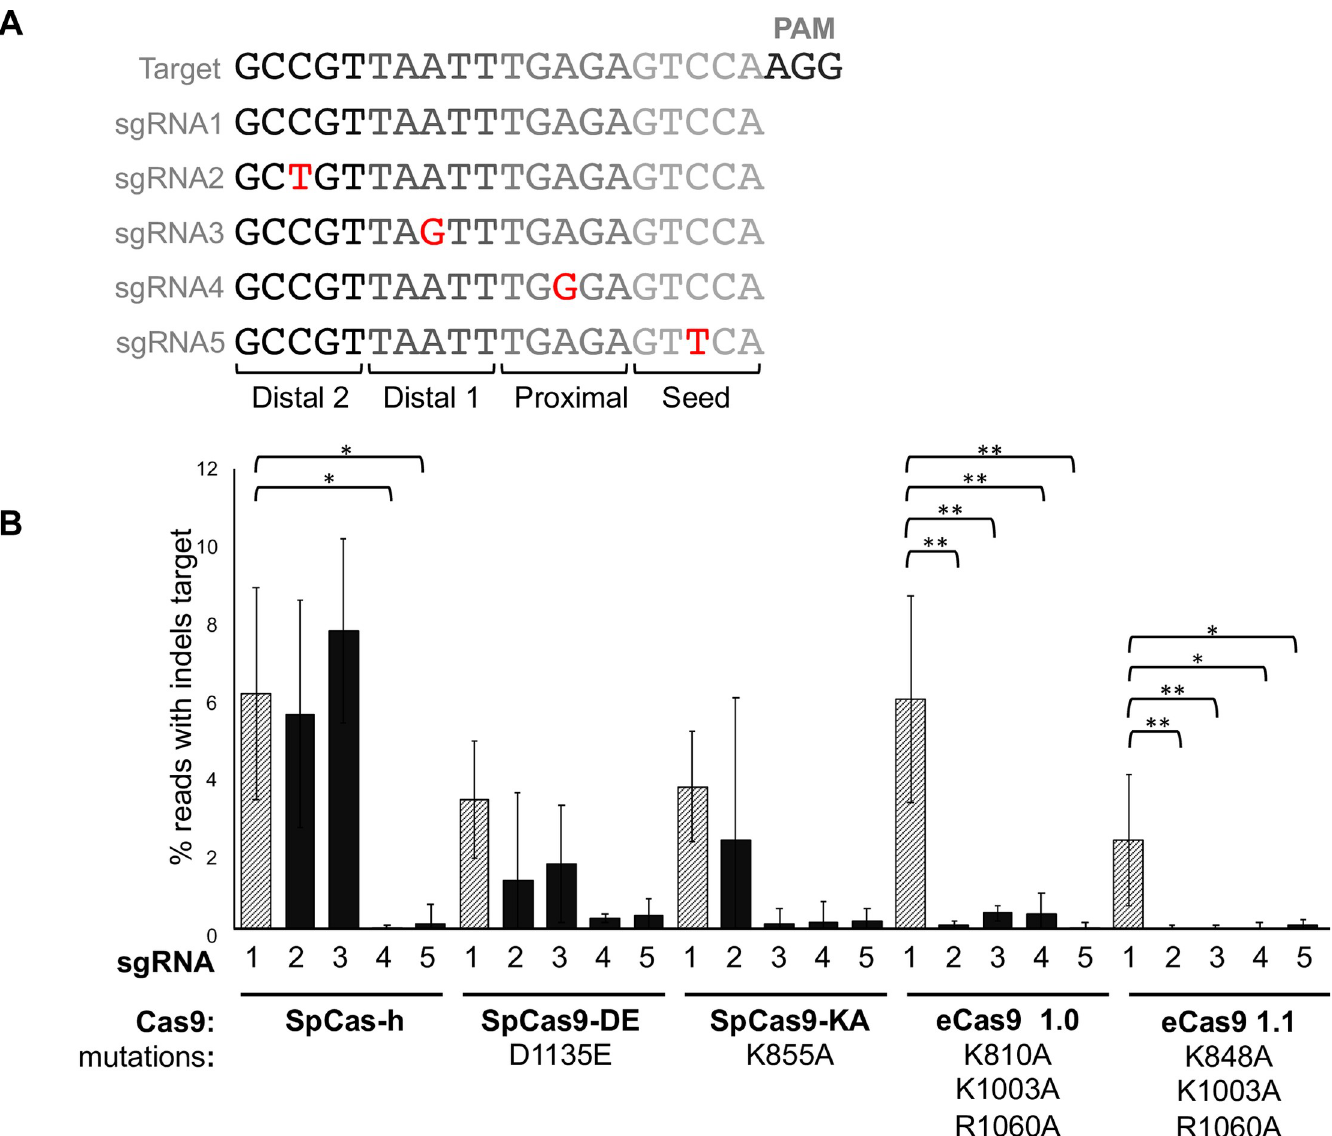
Fig 3. Assessment of Cas9 specificity at an identical target. (A) Schematic showing transversions in four regions of the spacer sequences of sgRNAs targeting NbPDS1 (B) The efficiency of targeted mutagenesis is impacted by transversions in the spacer. Shaded bars represent a perfect match of the spacer to the target, black bars show sgRNAs with spacers with transversions relative to the target. Error bars = standard error of the mean; n = 4. Post hoc comparisons using Tukey’s Honest Significant Difference test indicted significant differences: � = p < 0.05, �� = p < 0.01.